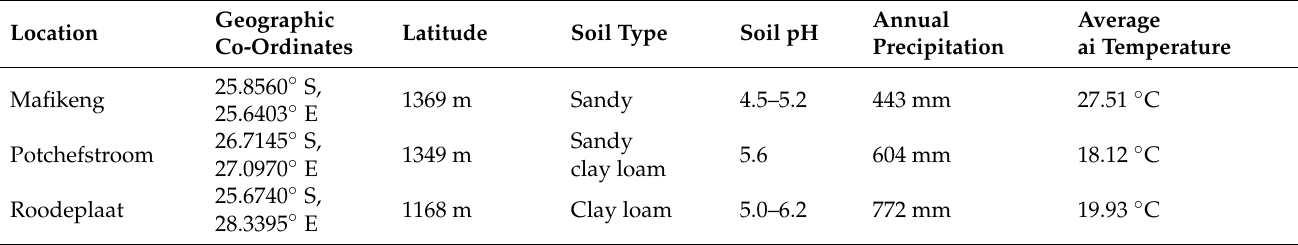
Table 2. Description of the locations used in the